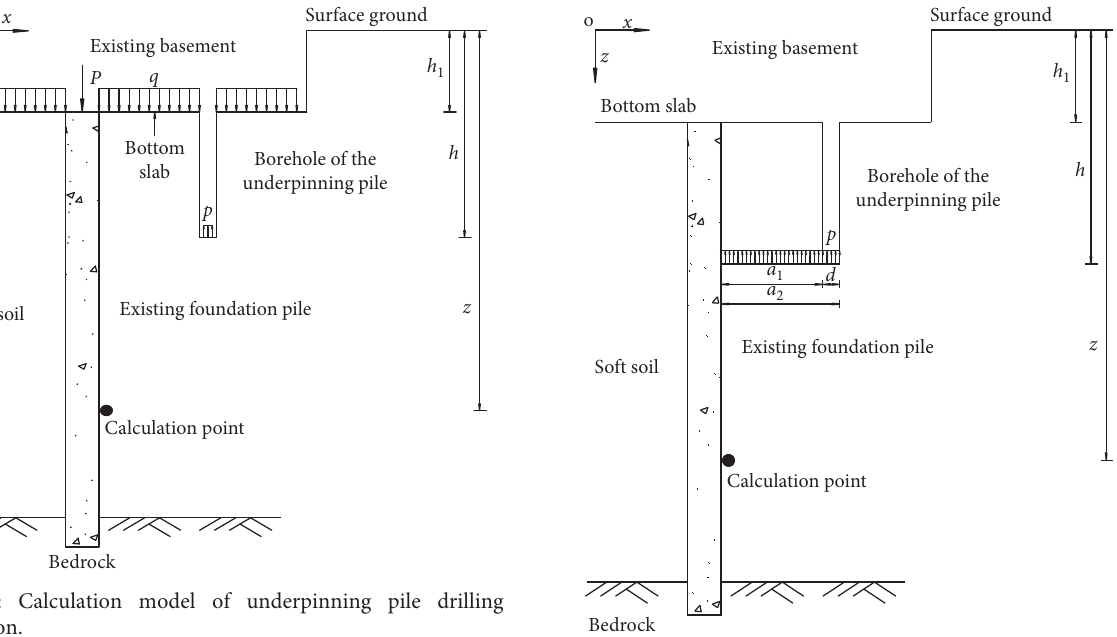
Figure 4: The sketch of the superposition